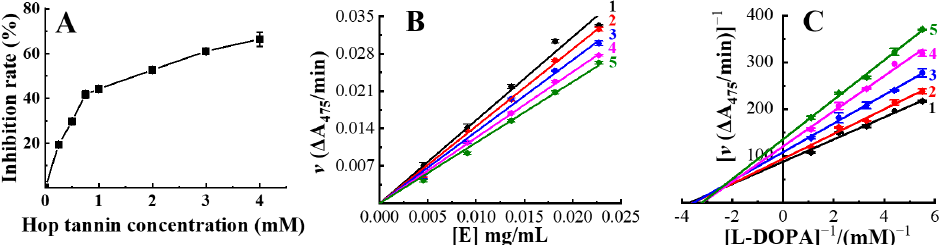
Figure 1. Tyrosinase inhibition rates provided by hop tannins with different tannin concentrations ( A ), inhibitory mechanism ( B ) and inhibitory type ( C ) of hop tannins on tyrosinase. Concentrations of condensed tannins for curves 1–5 were 0, 0.3, 0.6, 0.9, and 1.5 µM, respectively. Table 1. Tyrosinase inhibition activity of the hop tannins 1 .